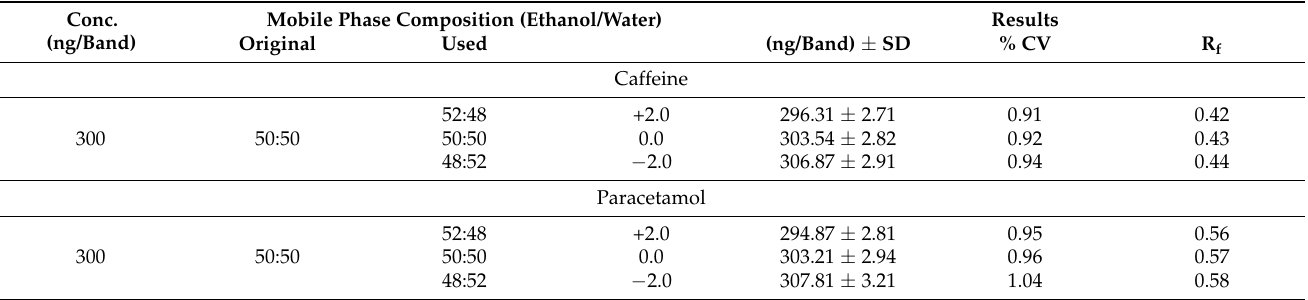
Table 10. Results of robustness analysis of caffeine and paracetamol for the greener reversed-phase HPTLC method (mean ± SD; n =